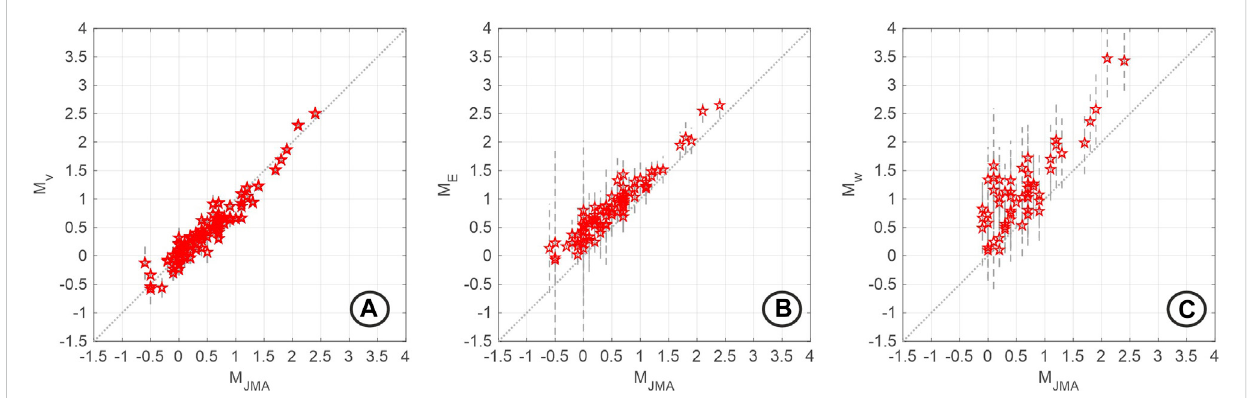
FIGURE 7 Magnitude estimates for the earthquakes identi fi ed by TREMOR in the Nagano region. From left to right, calculated M v (A) , M E (B) and M w (C) are plotted versus M JMA . M JMA stands for velocity magnitude calculated by